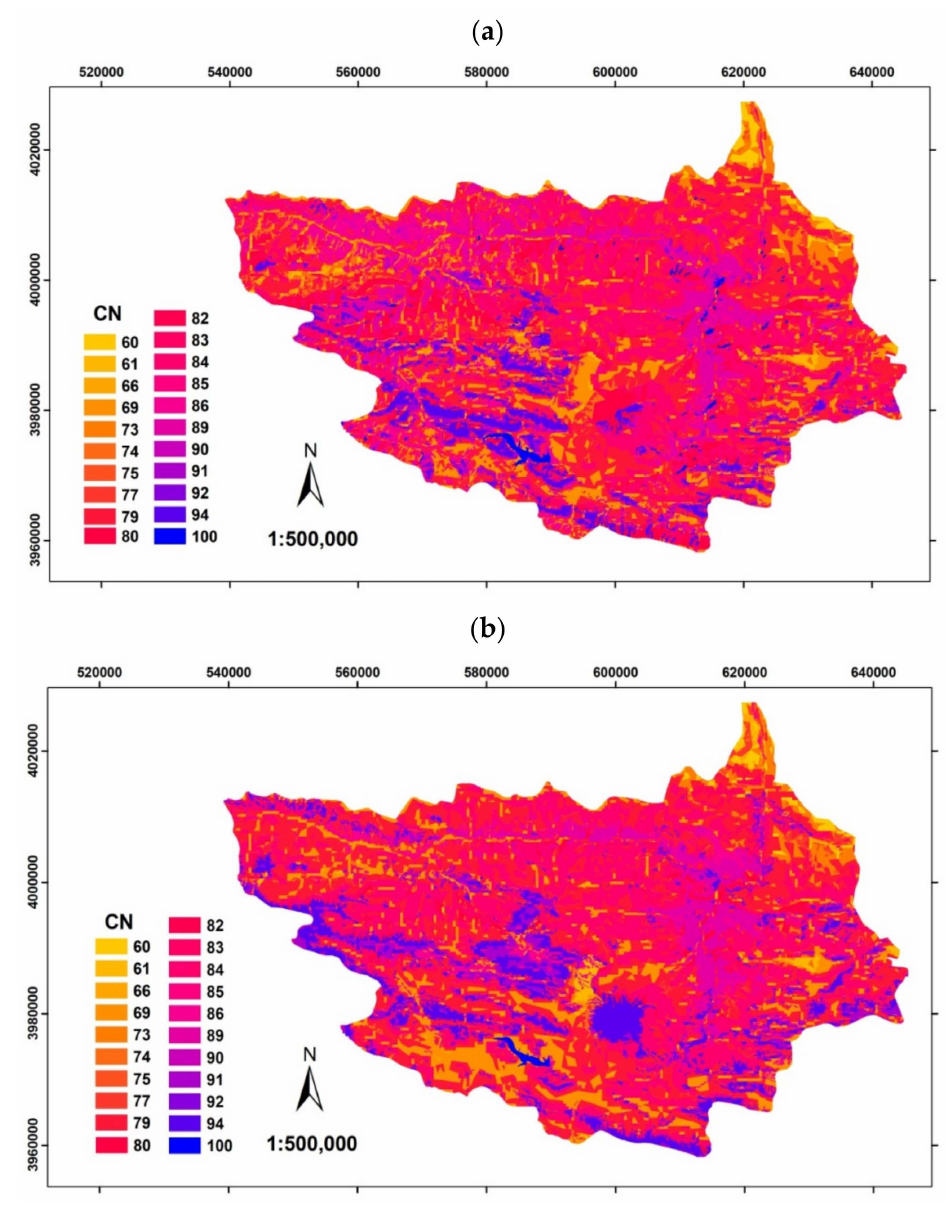
Figure 4. Curve number (CN) map of 1996 ( a ) and 2011 ( b